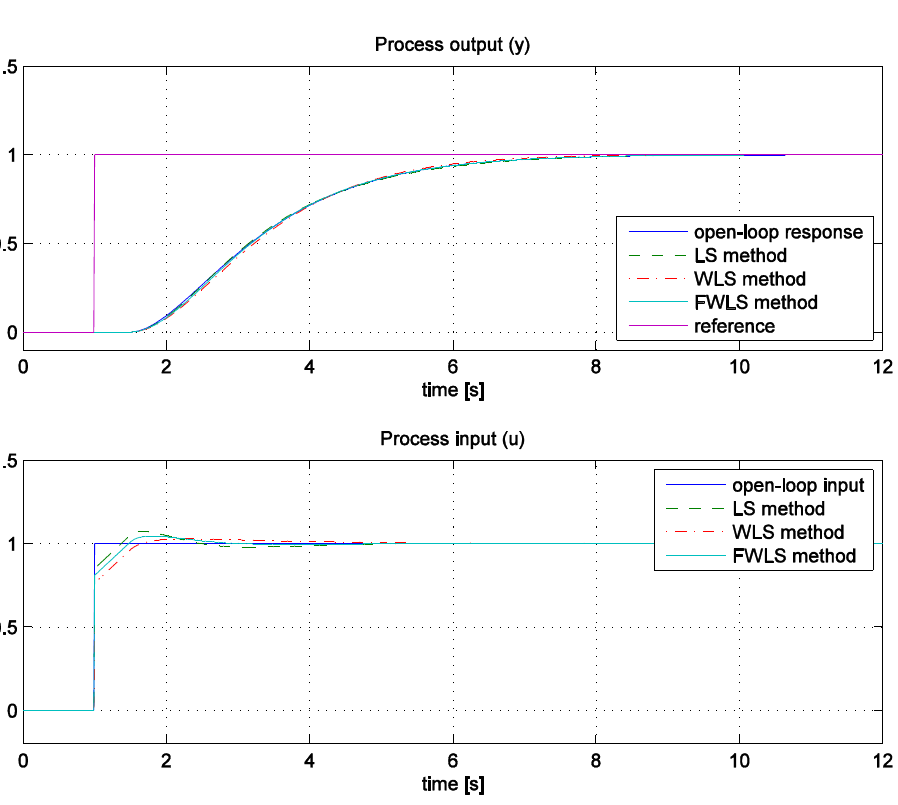
Figure 8. The comparison between the open-loop and closed-loop responses using LS, WLS and FLWS tuning methods. Table 1. The calculated PID controller parameters when using the LS, WLS and FWLS methods.